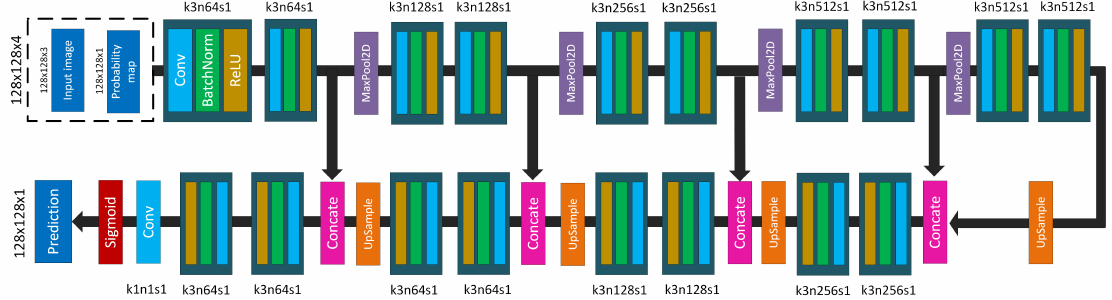
Figure 3. The Pach-Level Network architecture. The parameters of the convolution layer are: k is the kernel size, n is the number of channels and s is the